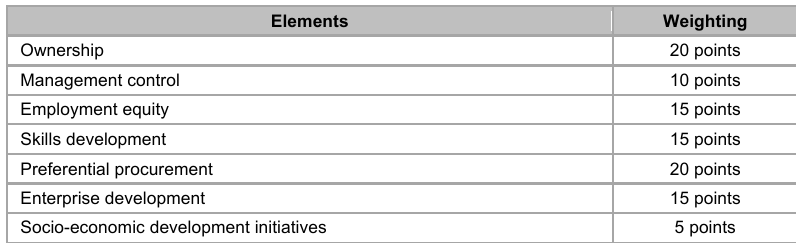
Generic scorecard: elements and